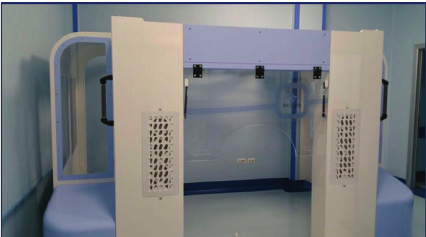
Figure 1: Arc Sterile in place: the structure has a frontal aperture for the entry of patients; on either side, two columns provide filtration of the air. Two sterile horizontal laminar flows are driven to the center of the cabin and cross themselves on the patient’s